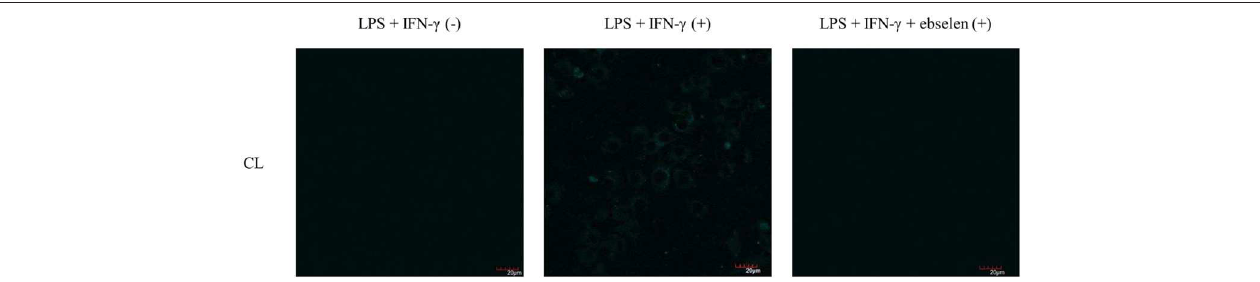
FIGURE 9 | Potential lysosome-targeting CL Probe detects ebselen-sensitive LPS and IFN- γ generated ONOO − in murine macrophages. RAW 264.7 macrophages were stimulated with LPS (1 µ g/ml) for 4h and IFN- γ (50ng/ml) and where indicated treated for 1h with ebselen (50 µ M). CL (20 µ M), was incubated for 30min. Blue channel: λ ex = 405nm, λ em = 420–460nm. Scale bar: 20 µ m. Magnification x60. n = 3.